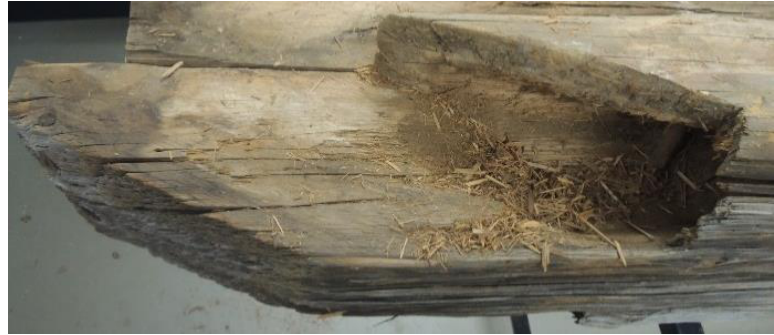
Figure 13. Damage to the beam (H2) in the location of the dovetail joint.